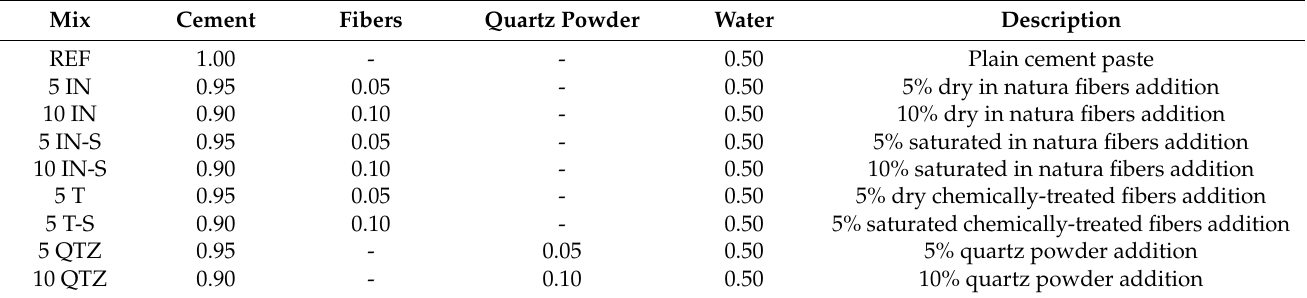
Table 2. Detailed composition of the pastes investigated (in weight